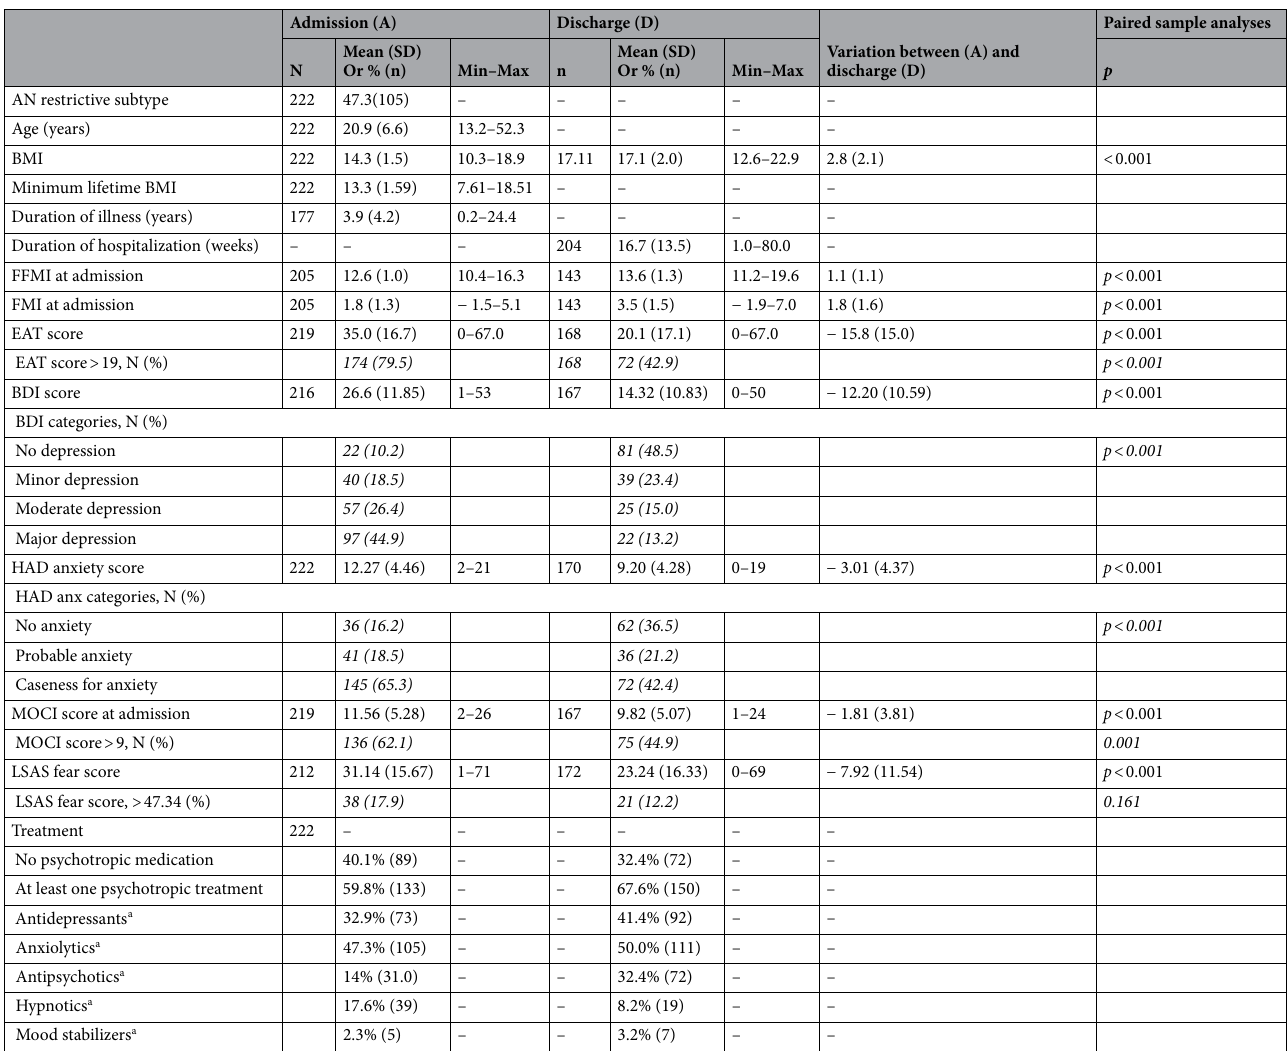
Table 2. Patients’ (n = 222) characteristics at admission and discharge. In italic: proportion of patients with scores above the cut-offs for the corresponding clinical scale (%). SD standard deviation, BDI Beck Depression Inventory, BMI Body Mass Index, EAT Eating Attitude Test, HAD Hospital Anxiety and Depression scale, MOCI Maudsley Obsessive–Compulsive Inventory, LSAS Liebowitz Social Anxiety Scale. a More than one treatment was possible—explaining % above